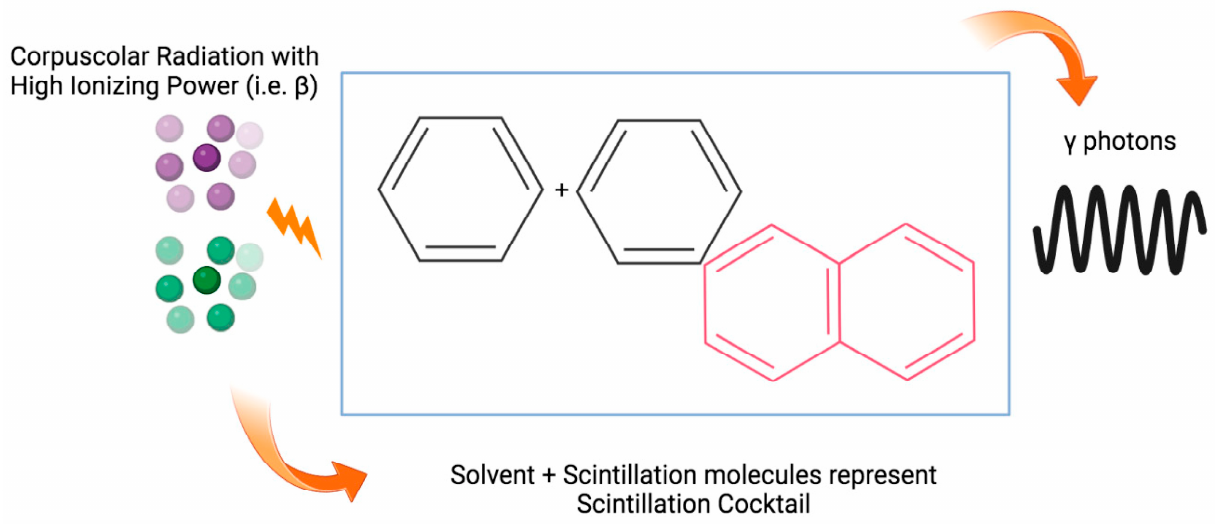
Figure 4. Mechanism of energy transfer in liquid scintillation